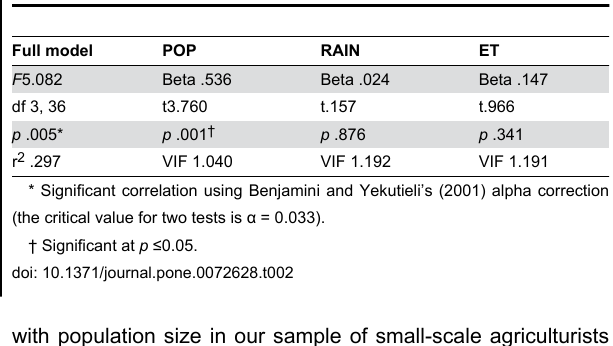
Table 2. Summary of results of standard multiple regression analysis carried out to assess the relative importance of population size (POP), mean annual rainfall (RAIN), and effective temperature (ET) as drivers of toolkit richness (STS) in a worldwide sample of nonindustrial food- producing societies (n = 40).